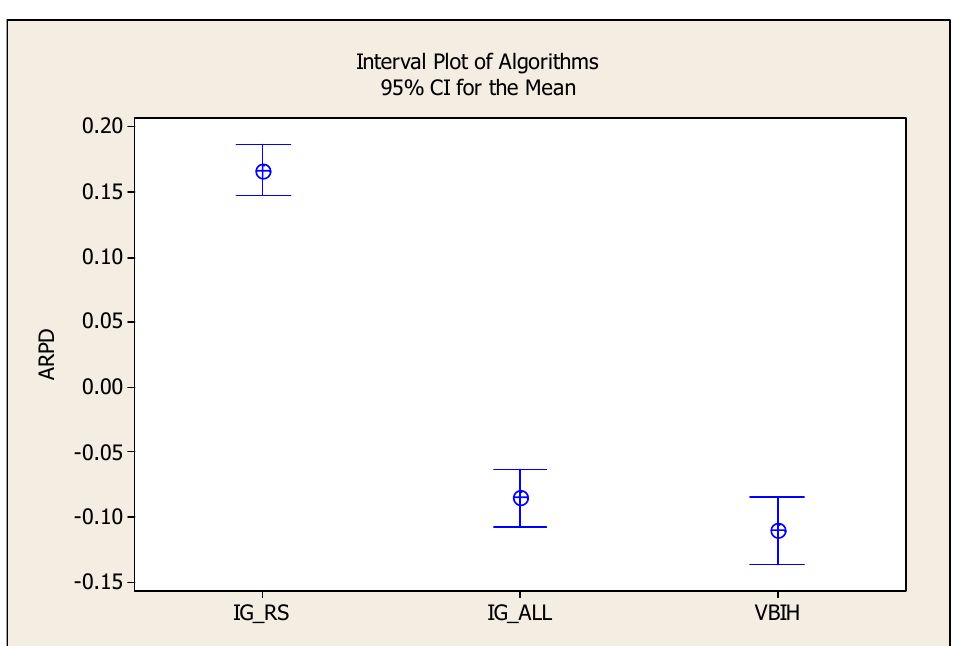
Figure 8. Interval plot at the 95% confidence level for large VRF instances.